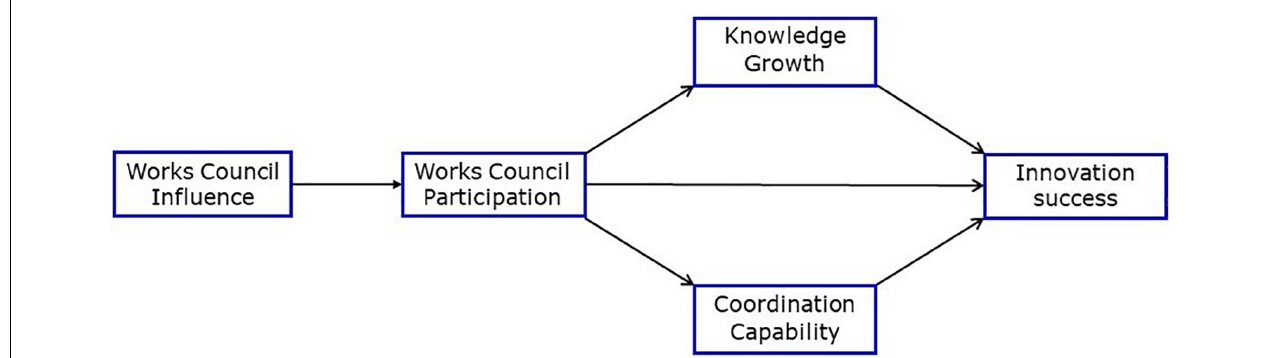
FIGURE 1 | Path model of works council participation in innovation